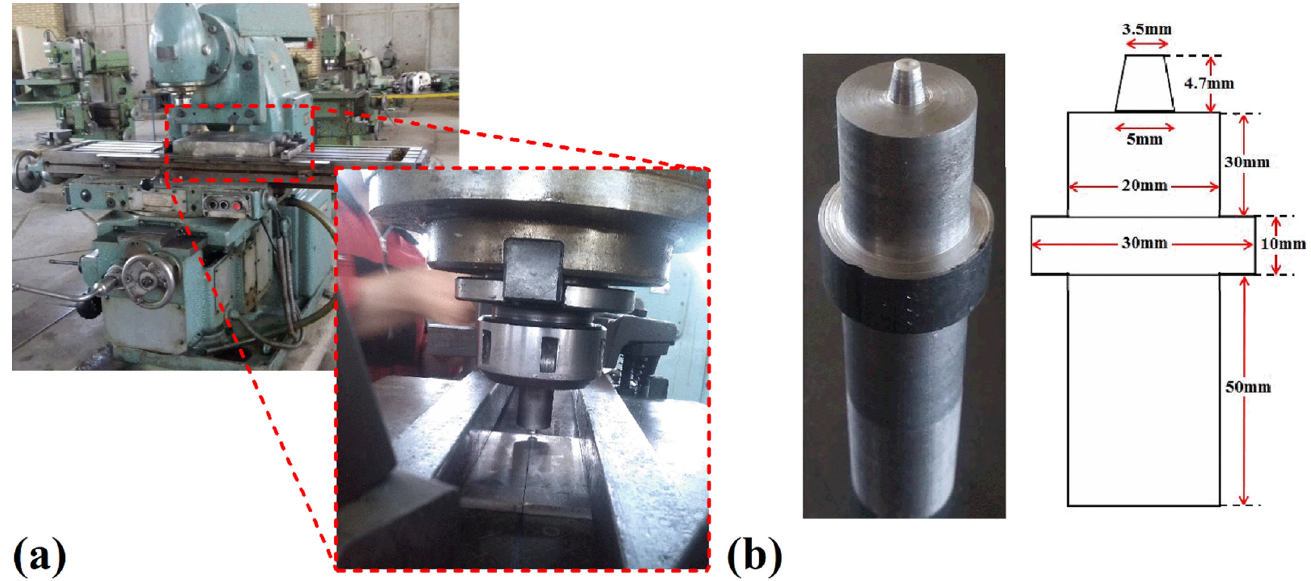
Figure 1. ( a ) FSW machine, ( b ) Tool used in FSW